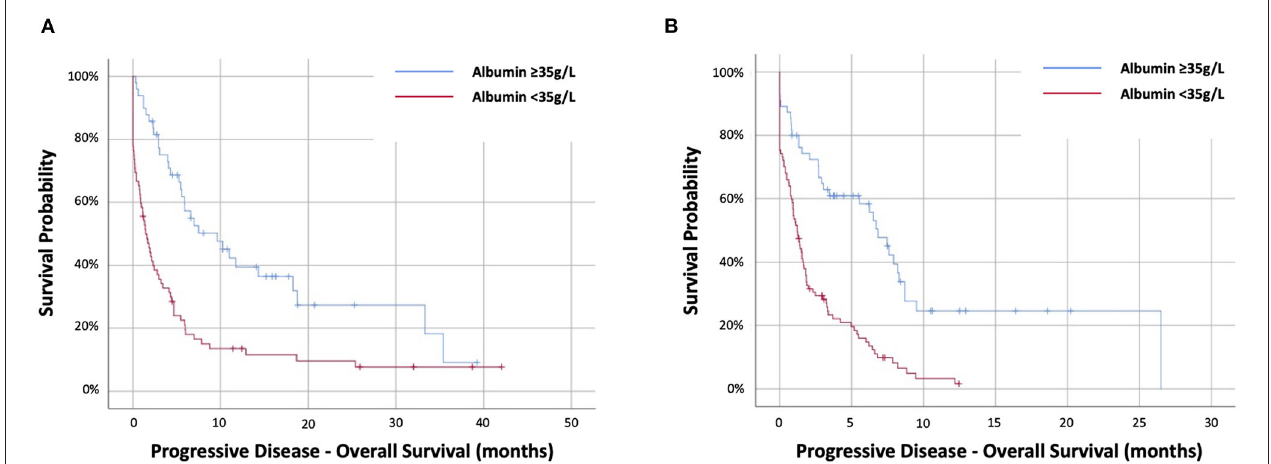
FIGURE 3 | Kaplan–Meier survival curves examing the relationship between progressive-disease albumin and progressive disease overall survival of patients with NSCLC treated with first-line (A) targeted therapy or (B) immunotherapy-based